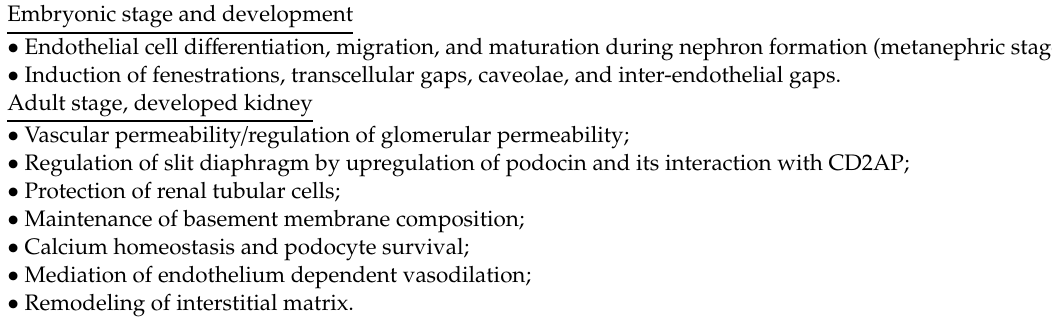
Table 1. Function of constitutively expressed Vascular Endothelial Growth Factor (VEGF) and VEGF receptors in the normal